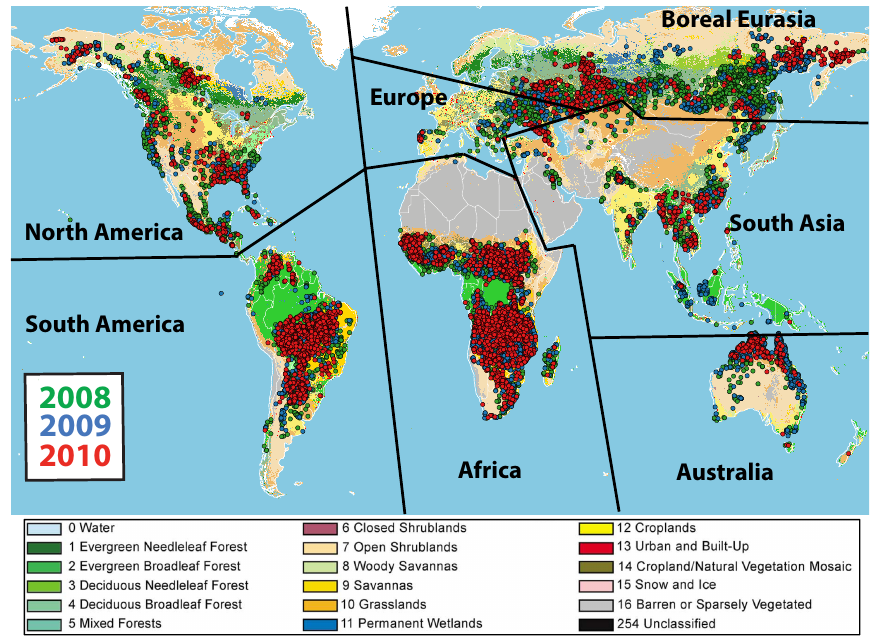
Figure 1. Geographic regions used in this study, and associated land-cover types, with dots indicating individual cases included in the